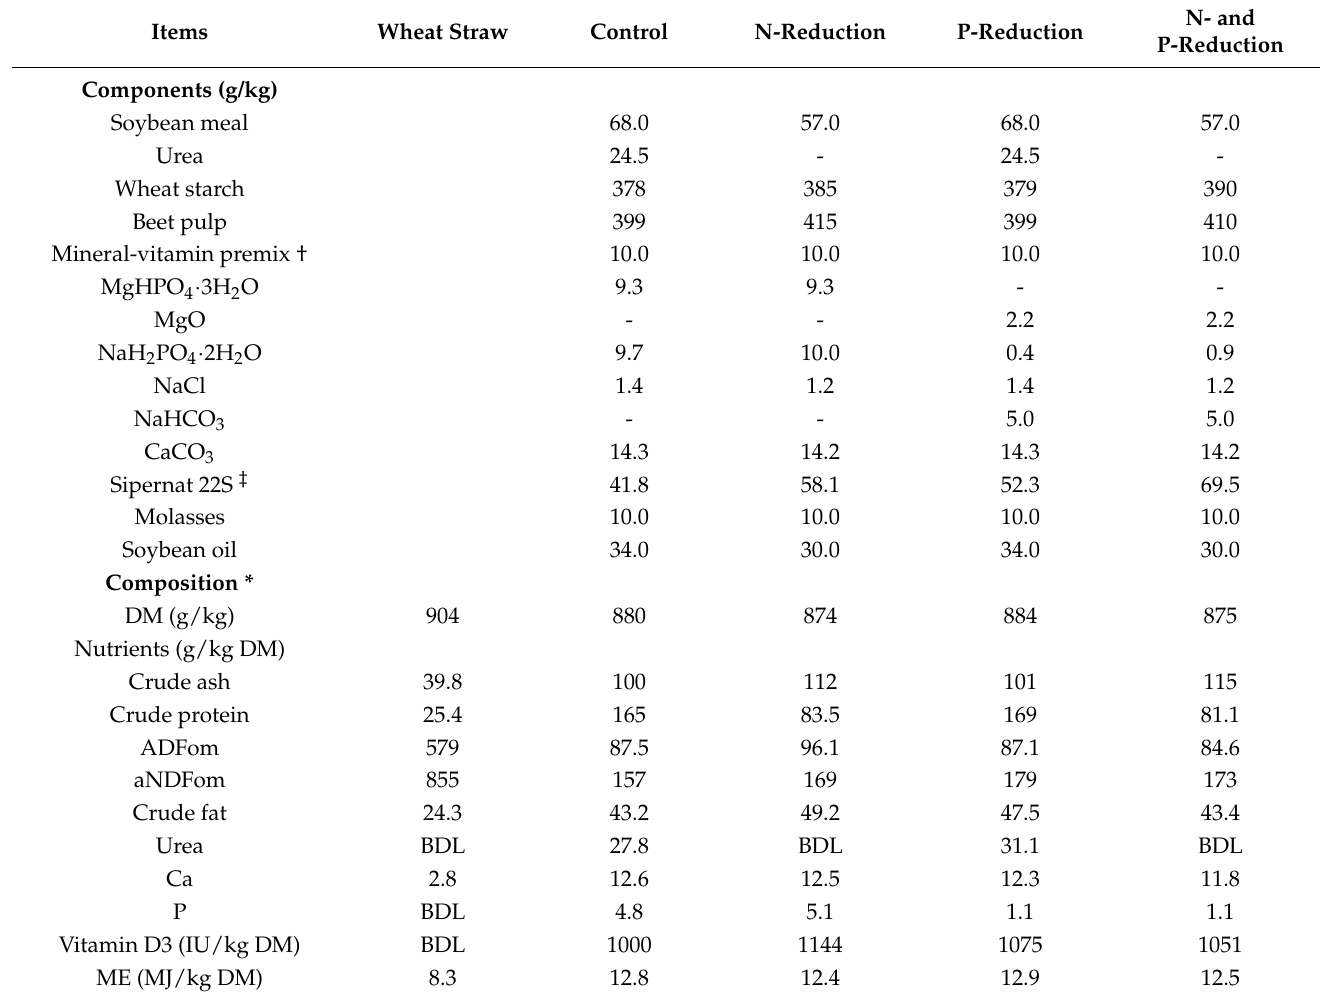
Table 8. Components and composition of wheat straw and pelleted concentrate